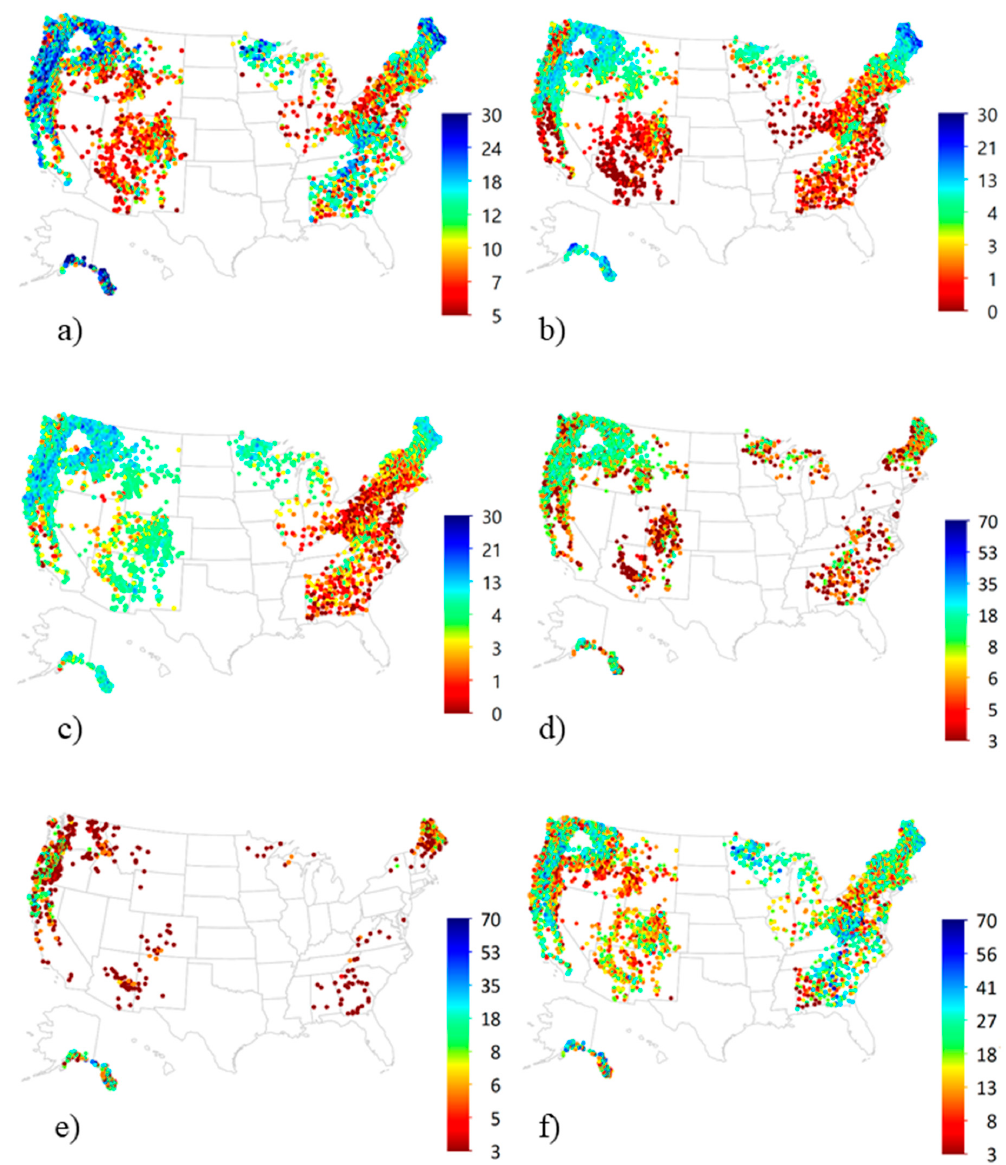
Figure 7. National maps of epiphytic macrolichen metrics for forests of the United States, 1990–2012: Species richness (count) of ( a ) all epiphytic macrolichens, ( b ) oligotrophs, ( c ) S- sensitive species; and diversity and abundance (sum ocular abundance ratings > 2) for ( d ) forage lichens, ( e ) cyanolichens and ( f ) matrix lichens. Sites with total species richness < 5 were not included in analyses. Table 5. Deposition (kg ha − 1 y − 1 ) associated with 0, 20%, 50% and 90% declines in species occurrences can be used to quantify the risk of extirpation for rare species from eutrophying or acidifying air pollutants. Species of rare lichens were randomly selected from the national dataset to represent each pollutant (Poll), sensitivity class (Sensitivity), area, and functional group (Fxl Gp). The last four column headings are the percentage decrease from maximum detection frequency from Table S2 in [19]; values are deposition in kg ha − 1 yr − 1 . Risk of extirpation is proposed as low at deposition levels associated with declines of 0–20%, moderate from 20–50%, high from 50–90% and very high for declines over 90%. Abbreviations: Oligo = oligotroph, meso = mesotroph, eut= eutroph, sens = sensitive, intm = intermediate, tol = tolerant, occ = occurrences, i.e. the number of times species was